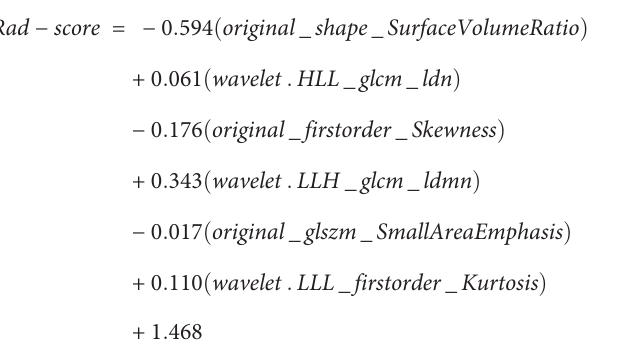
( Table 3 ). The fi nal regression equation and correlation coef fi cients were calculated. In Table 3 , the parameters in detail are reported. Using ROC curve analysis, the optimal cutoff value of the fi nal regression equation was 0.772. Lesions with values below the cutoff value are judged as benign, while those with values exceeding the cutoff value are judged as malignant.